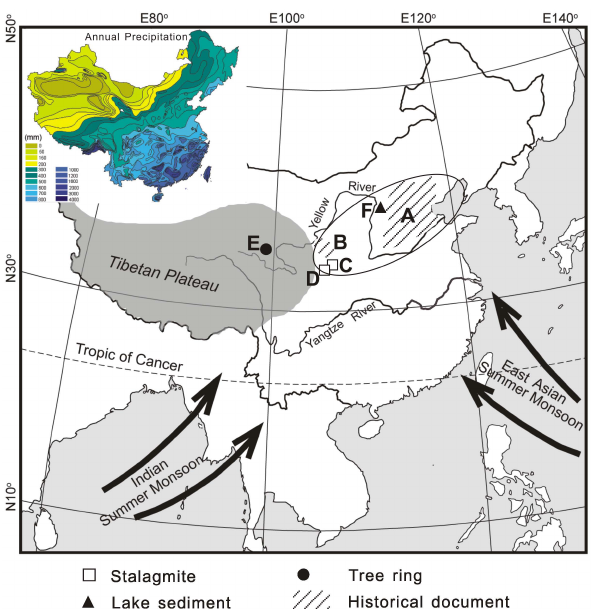
Fig. 2. The selected high-resolution precipitation records and the synthesized precipitation index for north central China during the last 1800 years. (A) Drought/Flood (D/F) index record of the Longxi area, with increased D/F index representing decreased pre- cipitation (Tan et al., 2008, 2010). (B) D/F index record for the Haihe River Basin, with increased D/F index representing increased precipitation (Yan et al., 1993). (C) Stalagmite δ 18 O record from Huangye cave, with lighter δ 18 O represents more precipitation (Tan et al., 2011). (D) Stalagmite δ 18 O record from Wanxiang cave, with lighter δ 18 O represents more precipitation (Zhang et al.,